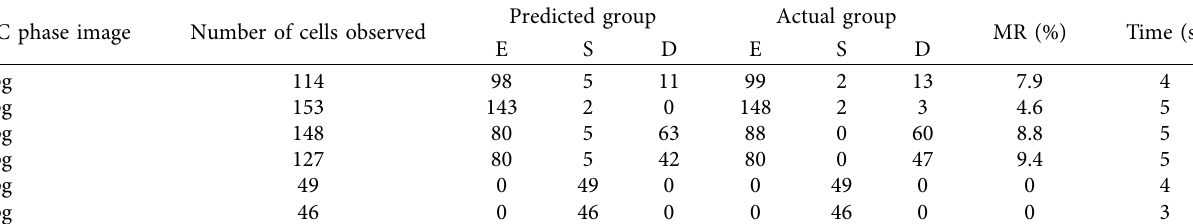
Table 2: RBC classification based on our